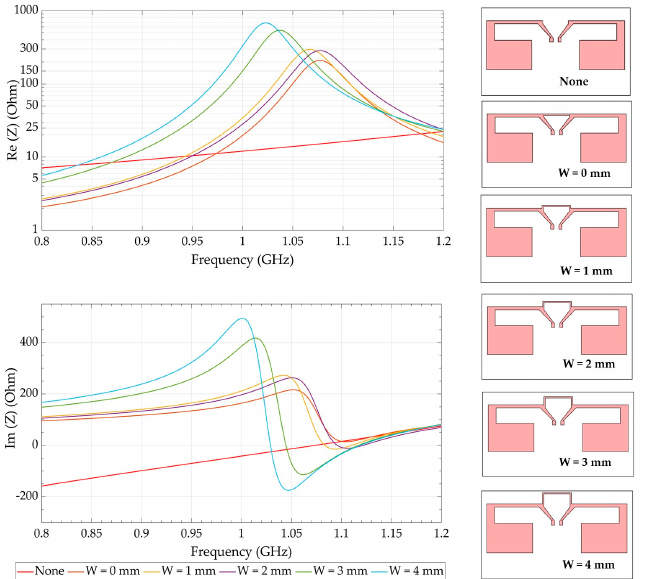
Figure 3. Evolution of the input impedance (Real and Imaginary parts) as function of the frequency with various shorting line width (W) values.